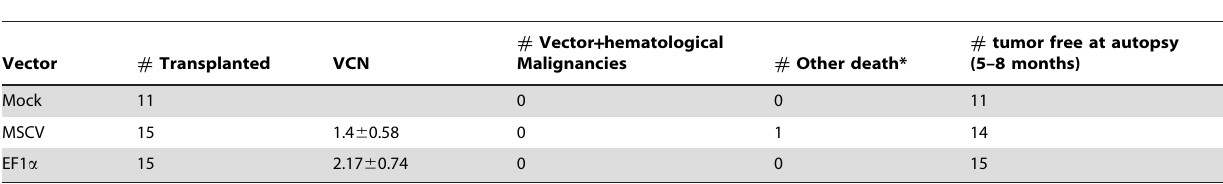
Table 1. Malignancy incidence in primary recipient mice in Exp. 1 (donor: c C 2 / 2 , recipient: c C 2 / 2 Rag2 2 / 2 ).